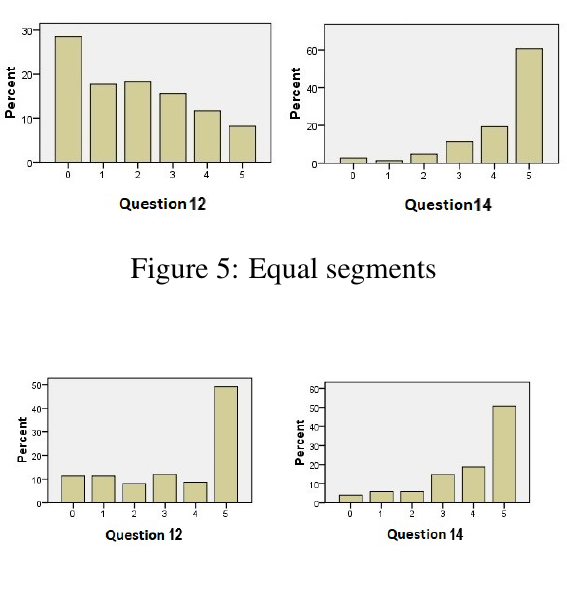
Figure 6: Equal-area